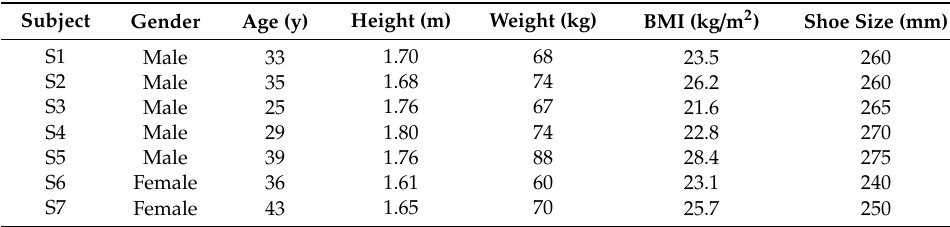
Figure 21. Terrains used for the tests (( a ) level ground, ( b )stair, ( c )ramp). The shoes in the figure indicate the start and end positions of the subject. The height of each step ( h step ) of the stairs is 165 mm. Table 3. Demographic characteristics of the subjects